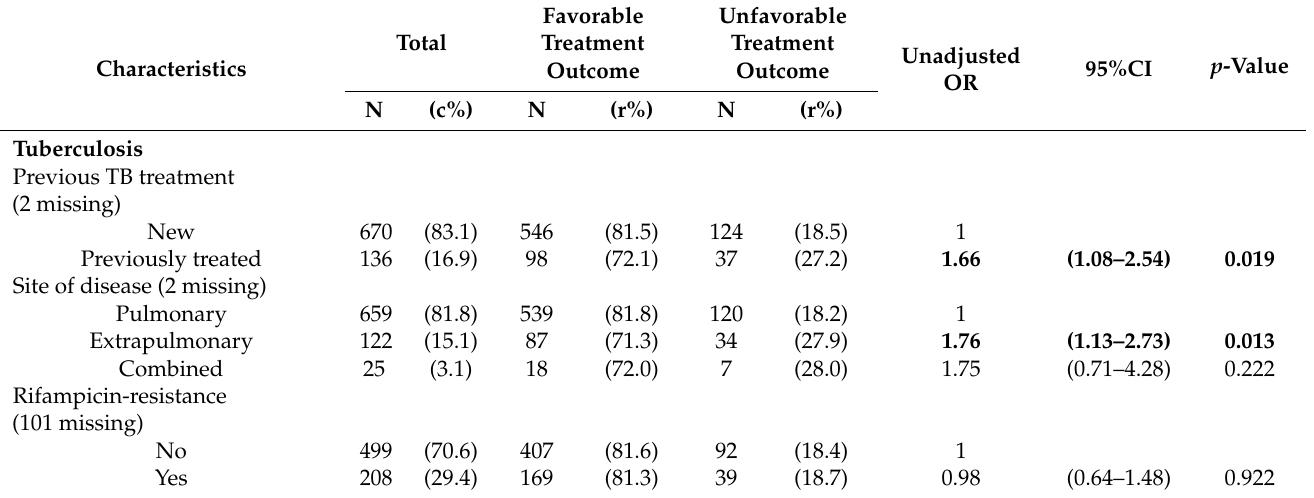
Table 2. Clinical characteristics among HIV-associated TB patients registered in Tashkent city, Uzbekistan (2013–2017) and their association with TB treatment